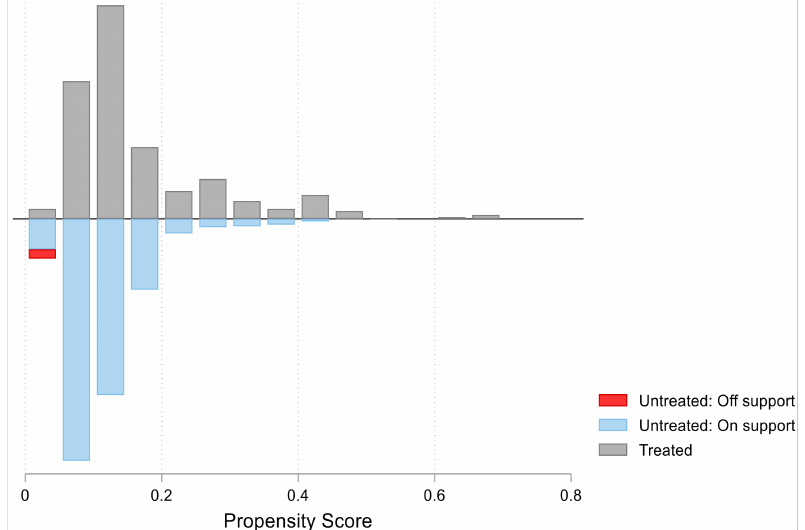
Figure 1. Density of the propensity scores for adopters and non-adopters of improved maize